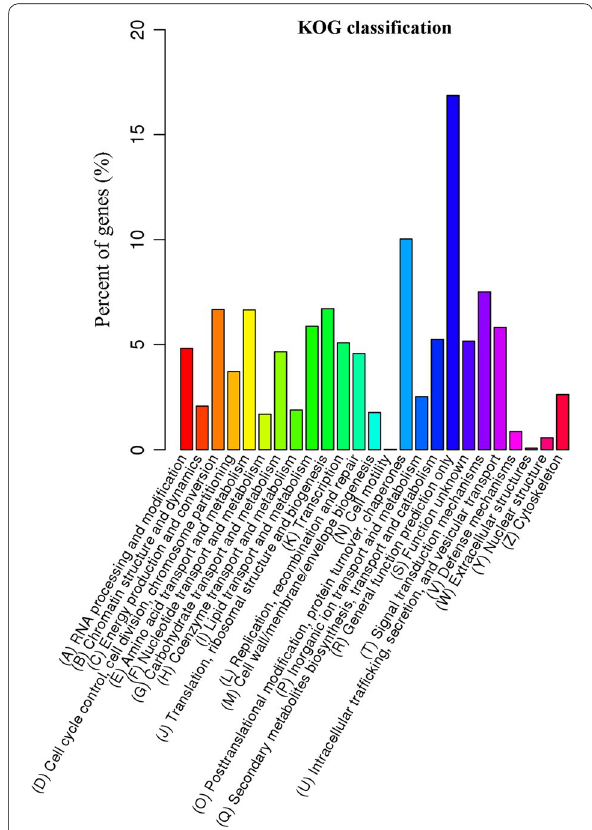
Fig. 3 KOG classification of the C. cladosporioides MD2 unigenes. The left y‑axis indicated the percent of genes in a category. The dominat‑ ing categories included ‘general function predictions only’ (827 uni‑ genes), ‘post‑translational modification, protein turnover, chaperones’ (492 unigenes), ‘signal transduction mechanisms’ (368 unigenes), ‘translation, ribosomal structure and biogenesis’ (329 unigenes), and ‘energy production and conversion’ (327